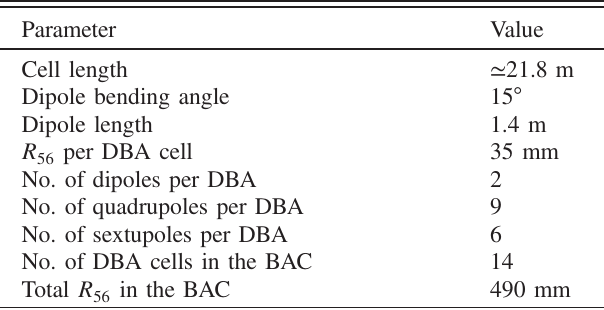
TABLE I. DBA and BAC main